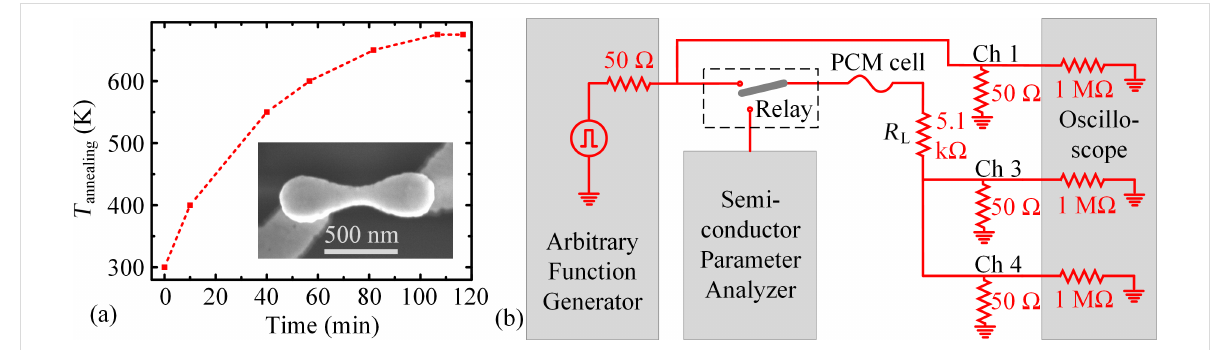
Figure 2: (a) Temperature profile used for annealing the as-fabricated amorphous devices to the crystalline phase, with a constant temperature of 675 K for the last 10 min. Inset shows the SEM image of an untested annealed GST line cell, with metal-to-metal L GST ≈ 470 nm, W GST ≈ 130 nm, and t GST ≈ 50 nm. (b) Electrical measurement